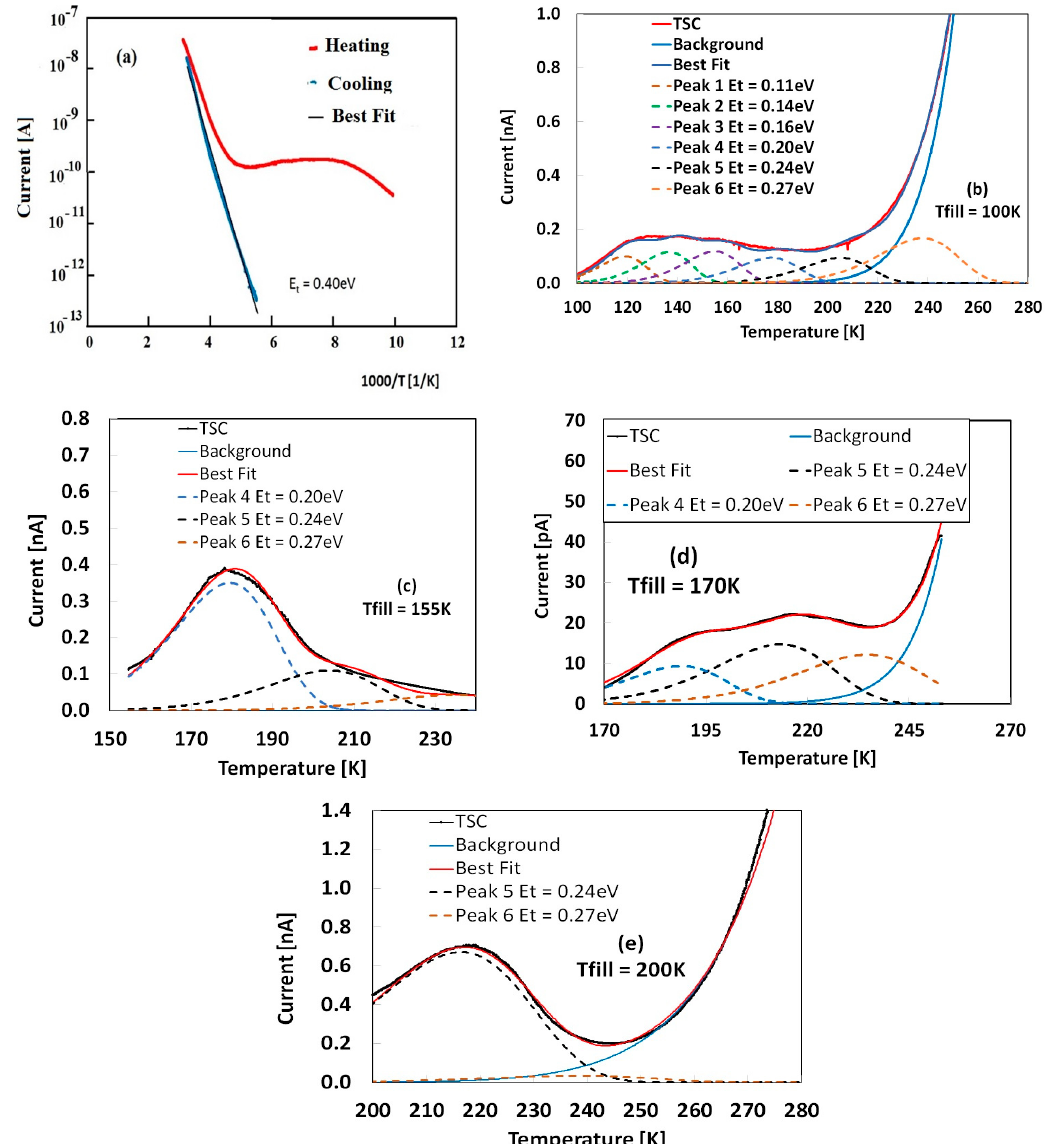
Figure 5. TSC after priming with a 400 nm LED source, V b = 5 V, β = 0.08 K/s. ( a ) T fill = 100 K, cooling scan thermally activated with E t = 0.40 eV. ( b – e ) Thermally stimulated current (TSC) obtained with filling at different temperatures T fill : ( b ) 100 K; ( c ) 155 K; ( d ) 170 K; ( e ) 200 K. Best-fit of curves shown